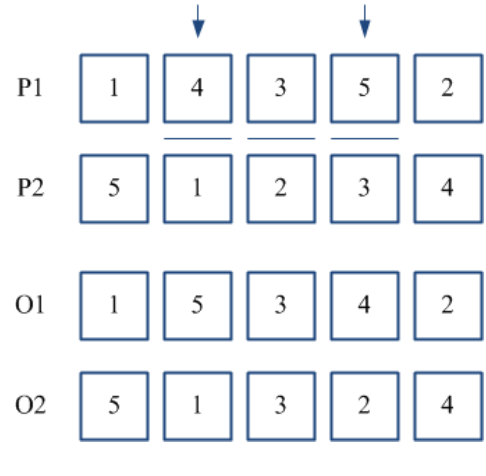
Figure 4. Two Point Crossover